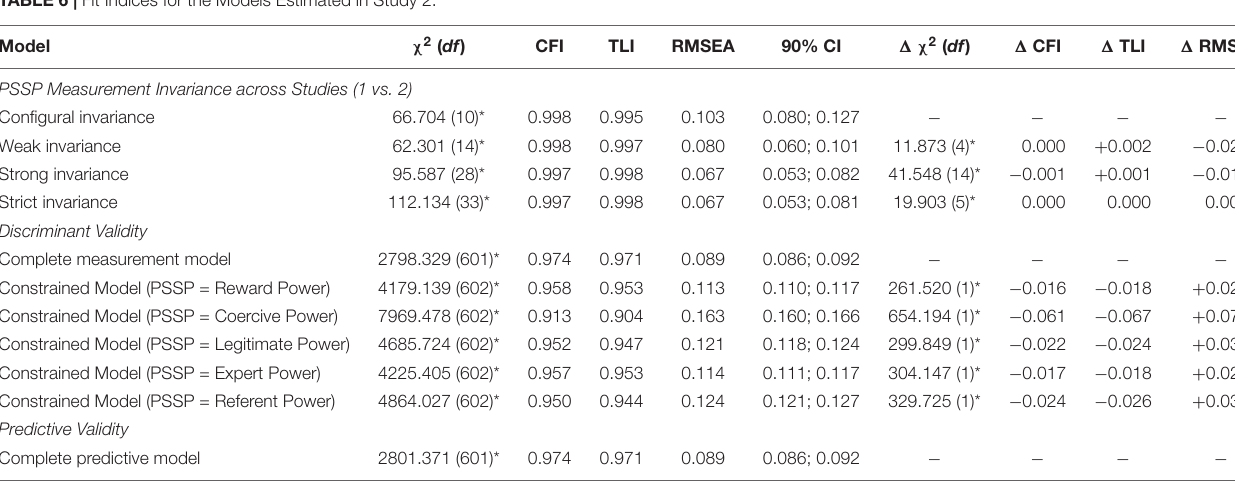
FIGURE 1 | Study 1 Simple Slopes for the Moderation Effect of Perceived Supervisor Social Power between Affective Commitment to the Supervisor and Organizational Commitment. TABLE 6 | Fit Indices for the Models Estimated in Study